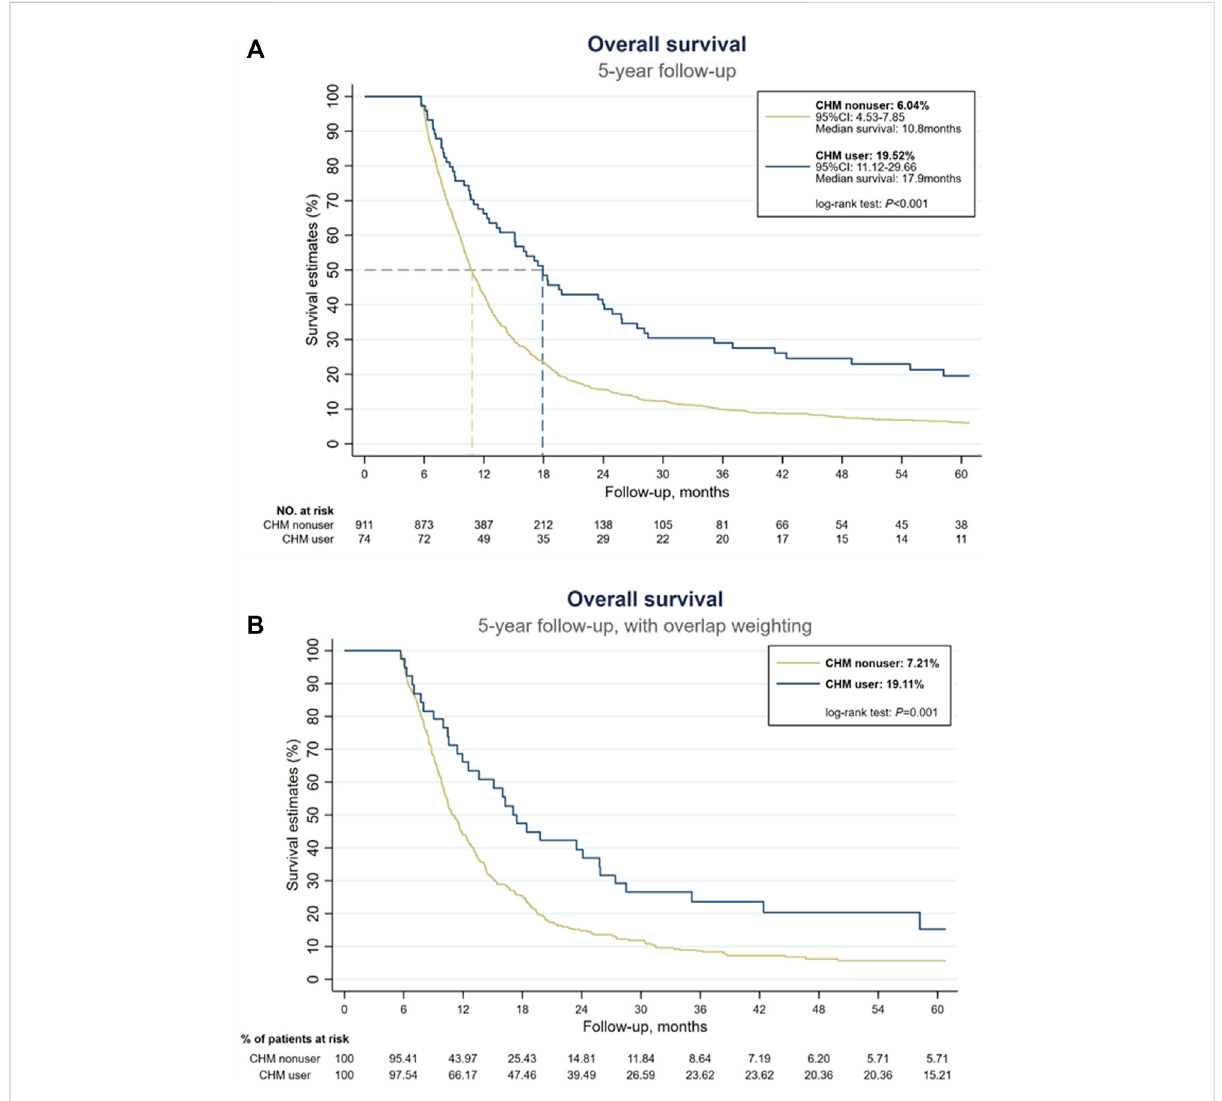
FIGURE 2 Kaplan-Meier estimates of overall survival of all stage IV esophageal cancer patients. (A) Without overlap weighting. (B) With overlap